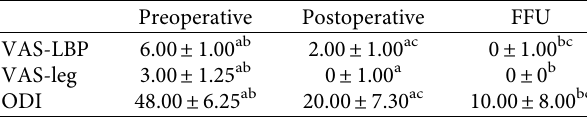
Table 2: Clinical outcome assessments (M ±